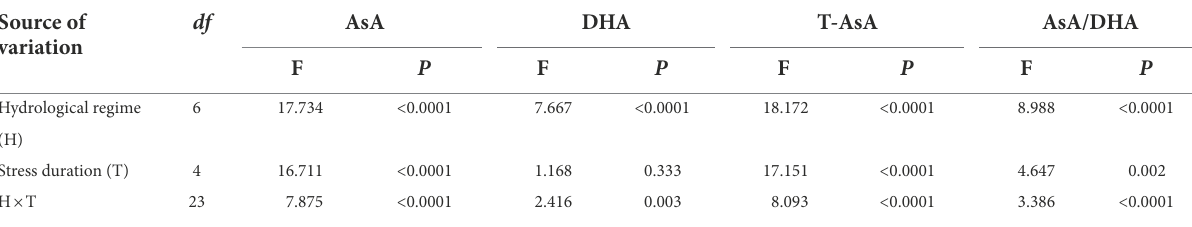
TABLE 2 Results of linear mixed models examining the effects of hydrological regime, stress exposure duration and their interactions on the contents of ascorbic acid in Deschampsia caespitosa. Source of variation